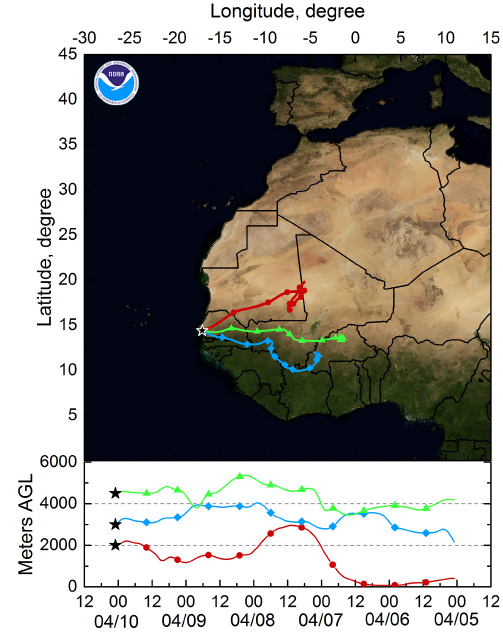
Figure 14. Five-day backward trajectories for the air mass in Mbour at altitudes of 2000, 3000, and 4500m on 10 April 2015 at 01:00UTC.